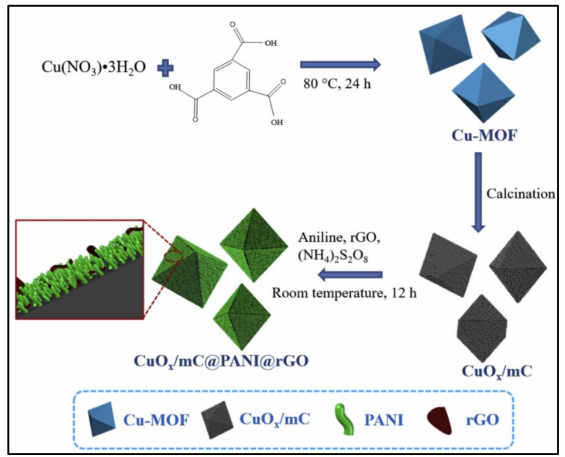
Figure 5. Schematic diagram of the preparation. Reprinted with permission from ref. [19] Copyrights © 2018 Elsevier Ltd.